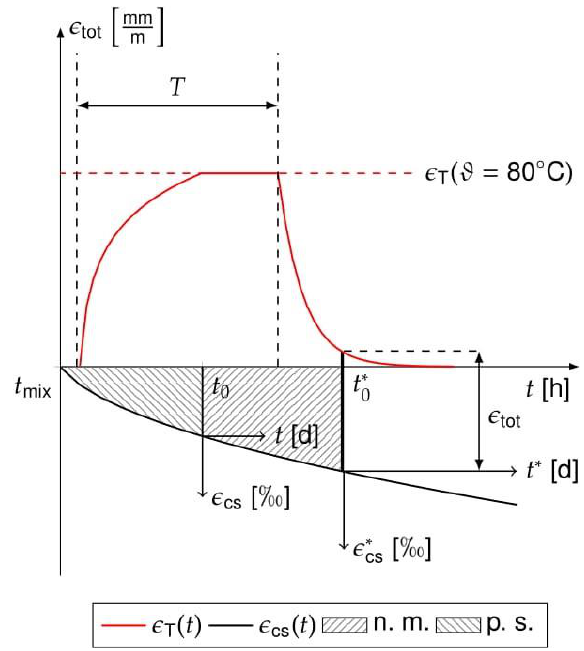
Figure 4. Temperature ε T and shrinkage strains ε cs during heat treatment.